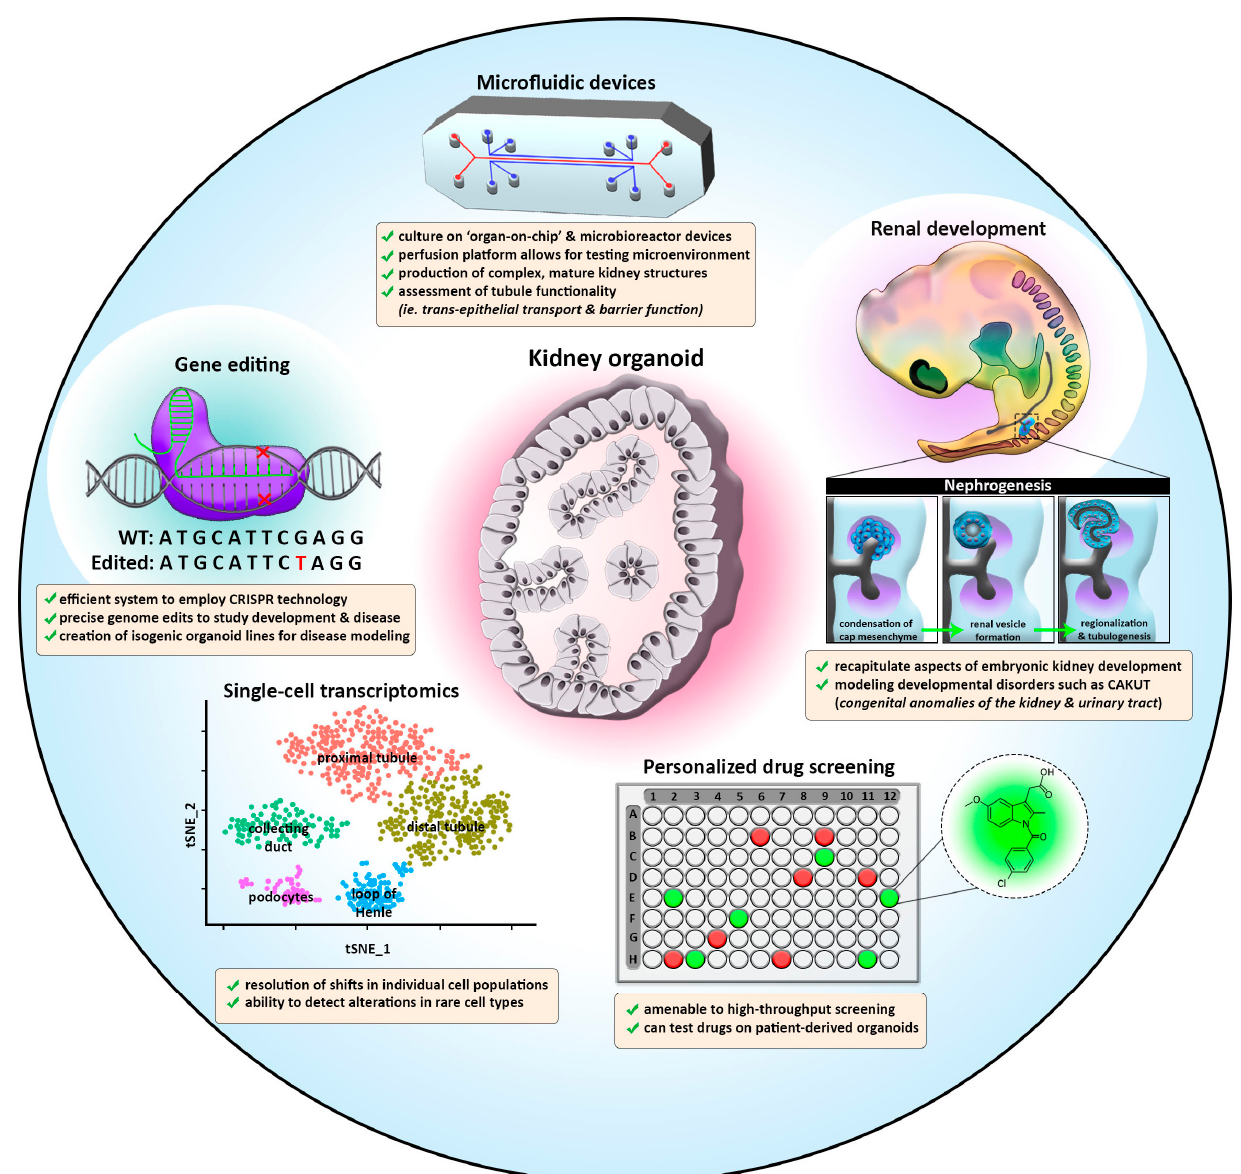
Figure 2. Diagram illustrating evolving applications of kidney organoid technologies. Microfluidic devices ( top ) create a platform for assessment of renal function and may enhance the differentiation of tubule epithelium due to continuous perfusion of secreted factors. Growing kidney organoids in vitro mimics processes of renal development ( top right ), like nephrogenesis, and can serve as a model for future studies on the molecular and cellular changes which transpire in congenital kidney diseases. Kidney organoids are amenable to personalized drug screening ( bottom right ) and may facilitate the discovery of novel treatment options as well as provide a much-needed platform for nephrotoxicology studies. The advent of single-cell transcriptomics ( bottom left ) has assisted the optimization of kidney organoid protocols and can help detect shifts in specific cell populations in disease contexts via clustering analysis. Kidney organoid models are an effective system to apply genetic engineering strategies ( top left ), like CRISPR-Cas9. The ability to produce precise genetic alterations and isogenic organoid lines will catalyze future discoveries concerning kidney development and